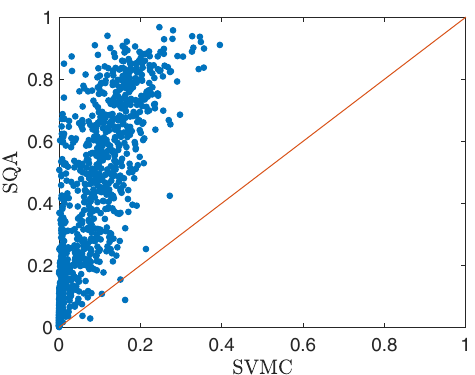
FIG. 18. Correlating the SQA and SVMC algorithm success probabilities. Shown is a scatter plot correlating the highest ground state probability for SQA (up to 2 M sweeps) and SVMC (up to 8 M sweeps) algorithms. For the results shown here both algorithms use the DW2X annealing schedule with an inverse temperature of β ¼ 2 . 5 .